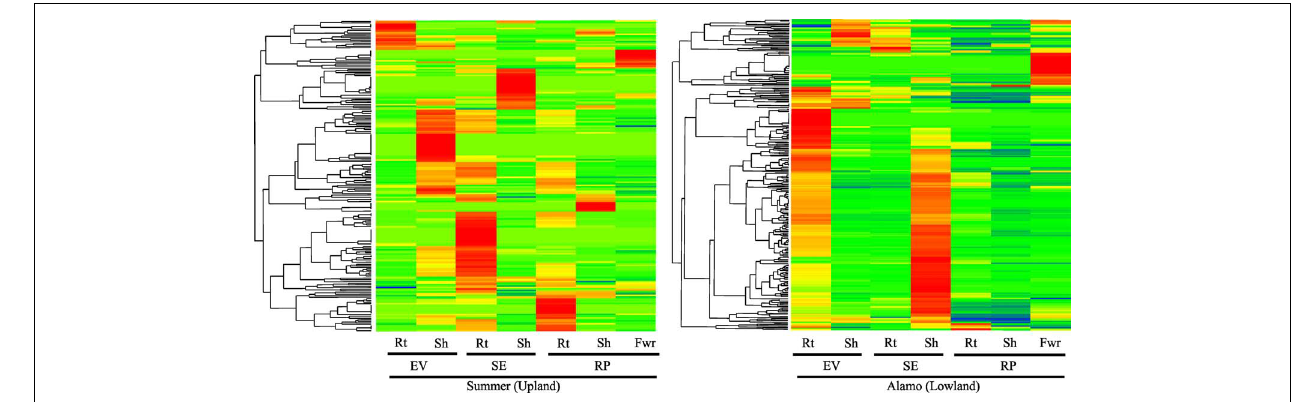
FIGURE 3 | One-way clustering color map for class III peroxidase expression profiles (z-scores) for publically available NGS datasets for cultivars Summer andAlamo. Stages of plant development are early vegetative (EV), stem elongation (SE), and reproductive (RP) are as described